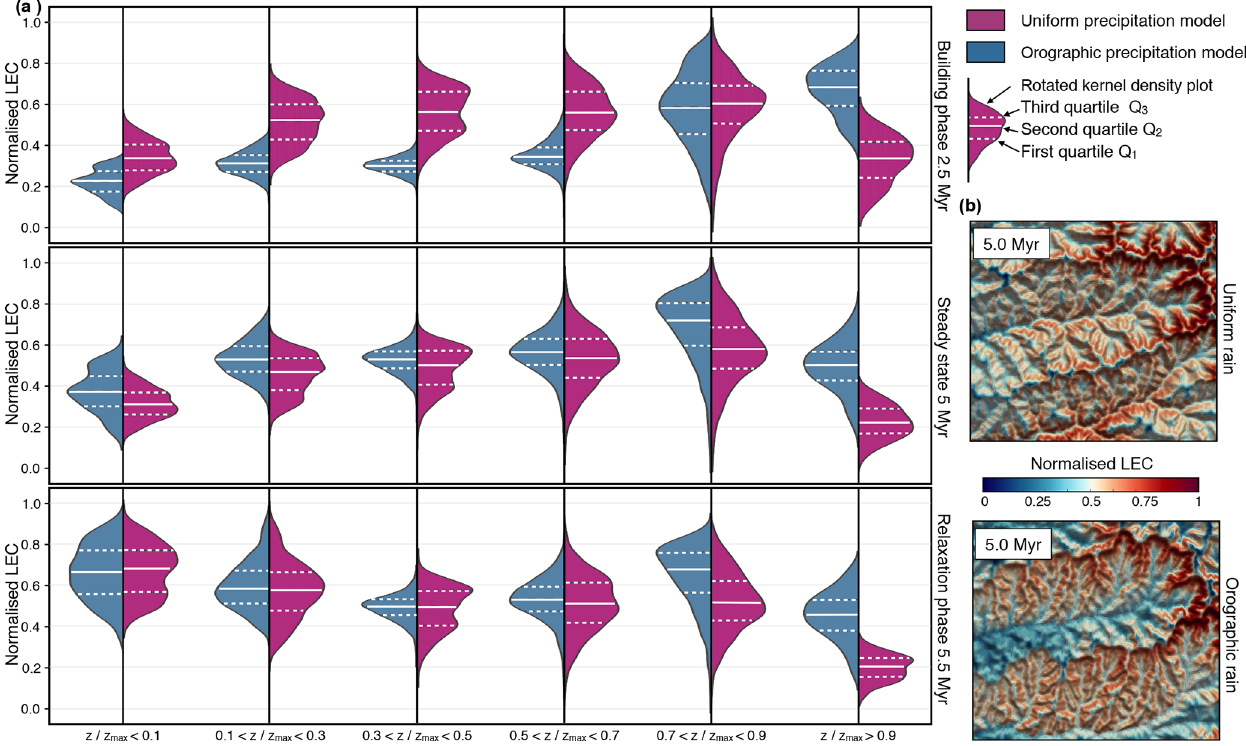
Figure 9. Temporal and spatial statistical analysis of normalised LEC based on categorical elevation data (defined within six bands of z/z max ) for both the uniform and orographic precipitation models. (a) Violin plots depicting the kernel density estimation of the normalised LEC distribution. White dashed lines in the violin plots show the location of the lower quartile ( Q 1 ) and the upper quartile ( Q 3 ). Solid white lines define the median ( Q 2 ) of the data set. (b) Comparison of the spatial distribution of normalised LEC at 5Myr for the two considered climatic scenarios. The data used for the statistical analysis presented in panel (a) have been extracted from these maps. The considered area corresponds to the highlighted region C defined in Fig.